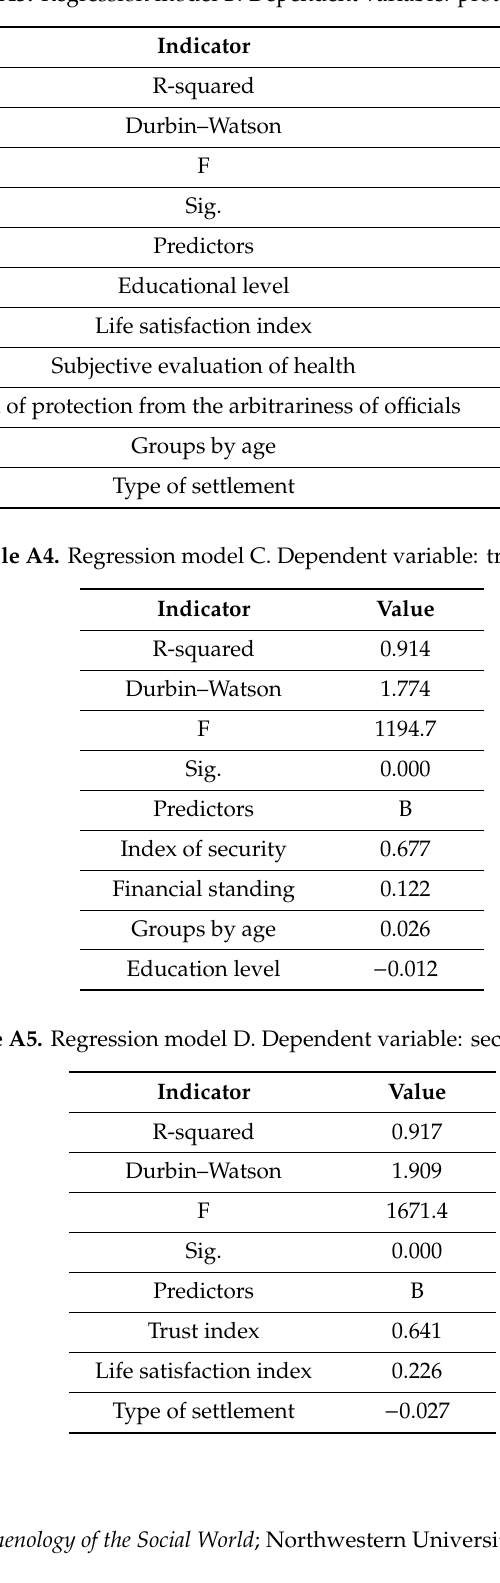
Table A3. Regression model B. Dependent variable: protest potential.